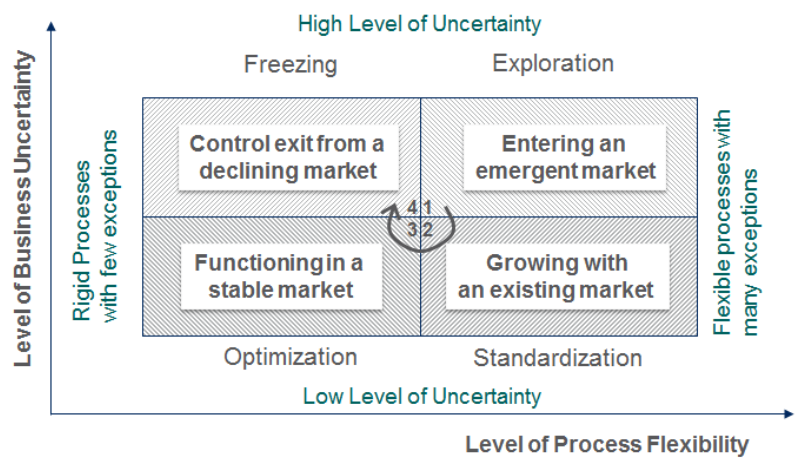
Figure 11. Marketing positions that defines a type of context for a business process